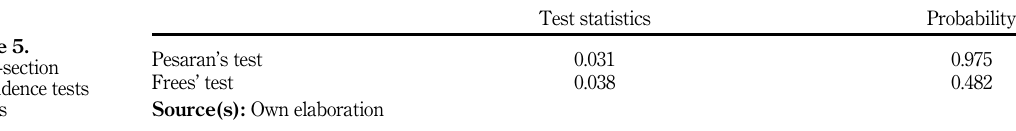
dependence tests